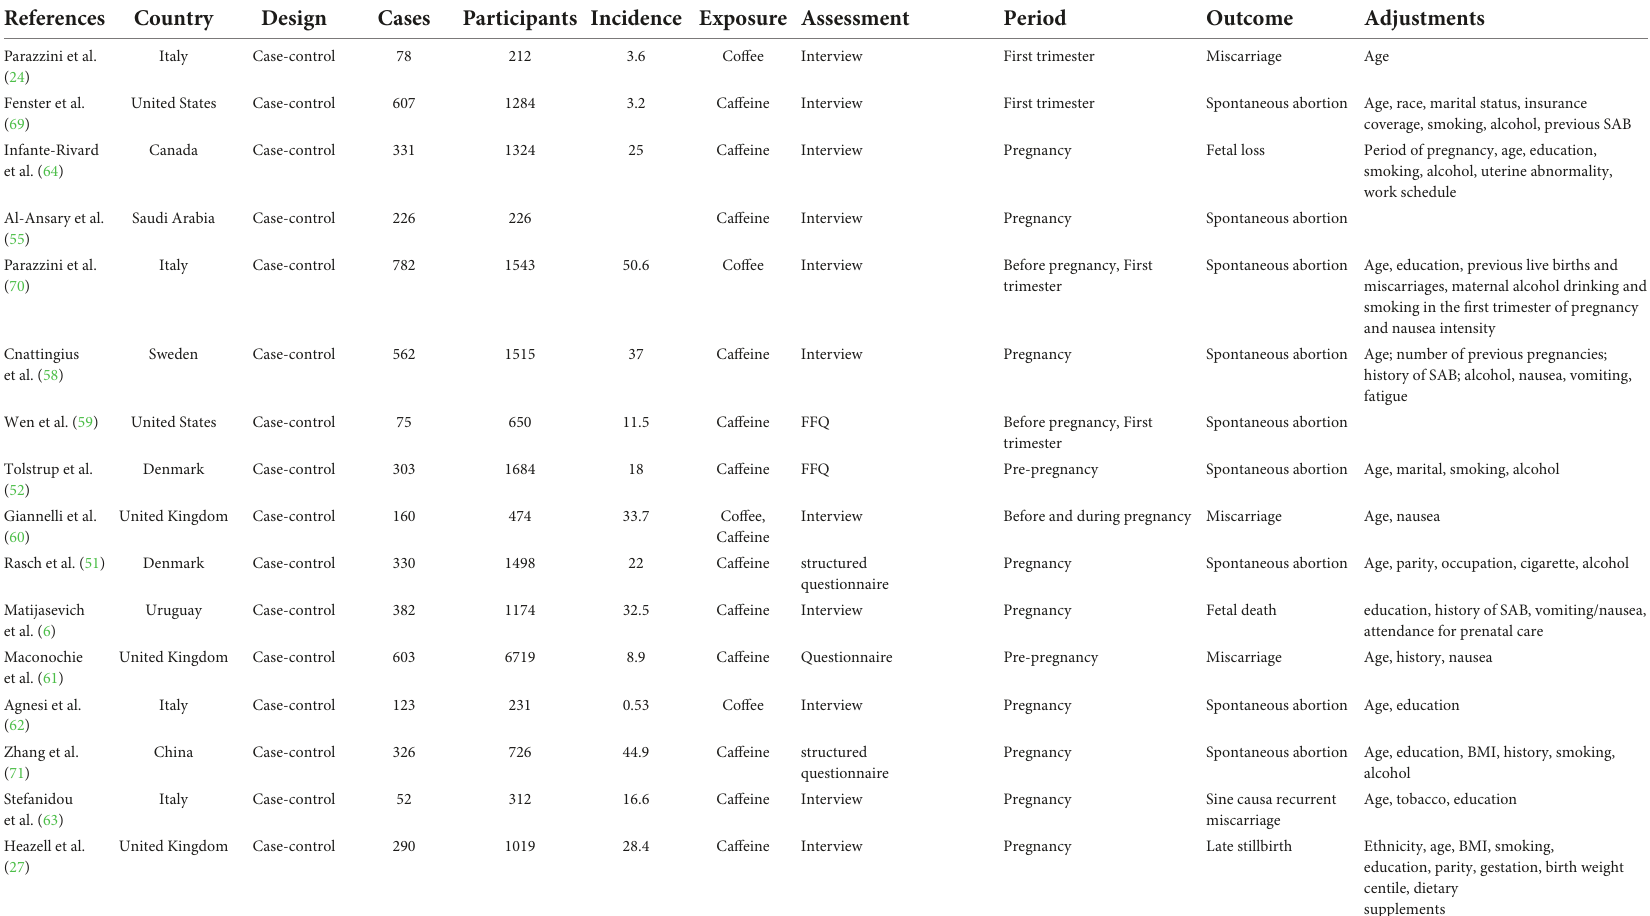
TABLE 2 Characteristic of included case-control